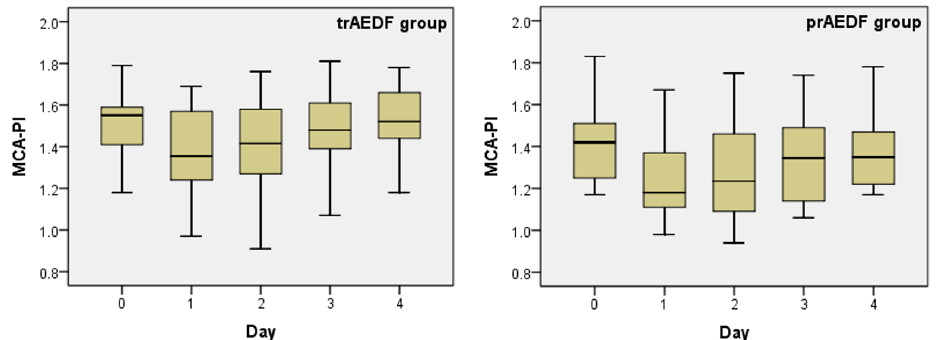
Table 4. The characteristics of the pulsatility index in the middle cerebral artery (MCA ‐ PI) prior (day 0) and in the first 4 days after maternal dexamethasone administration in the two groups. (tr/prAEDF = transiently restored/persistent absent end ‐ diastolic flow in umbilical artery group).